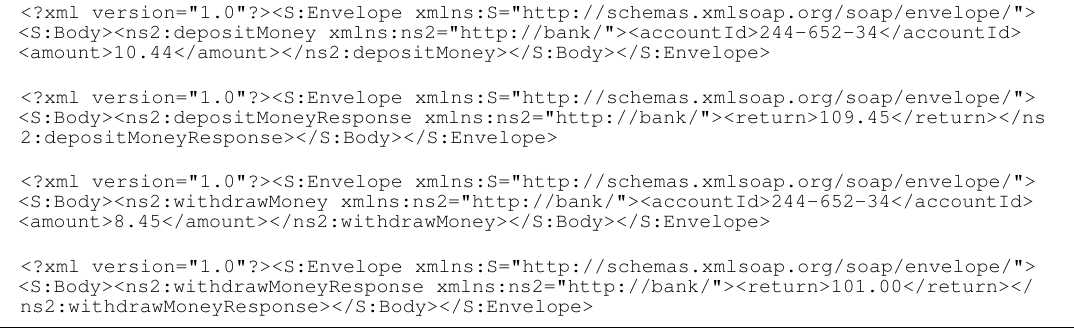
Figure 2. Two request and response messages of a SOAP banking data